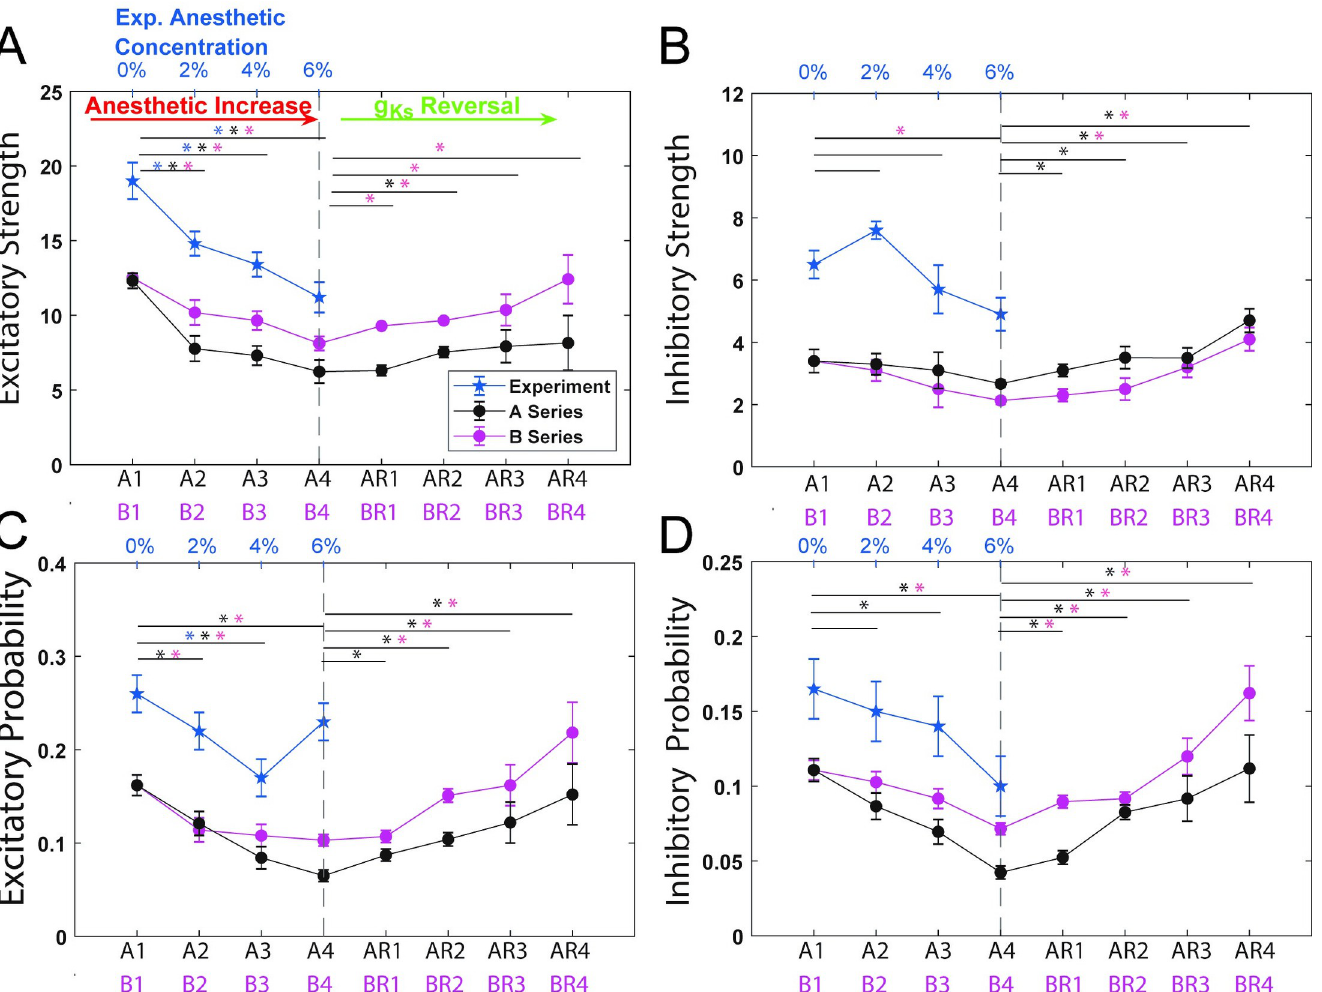
Fig 5. Characterization of anesthetic effects on network connectivity and their simulated ACh reversal. Measures of network connectivity computed from experimental data and optimized model networks as a function of anesthetic concentration and simulated reversal level: A) network excitatory connectivity strength, B) network inhibitory connectivity strength, C) network excitatory connectivity probability, D) network inhibitory connectivity probability. A1-AR4/B1-BR4 (x-axis) denote simulated anesthetic concentration levels and reversal states obtained in optimized networks with corresponding parameters listed in Table 2 . Blue line (with corresponding axis labels on the top) denotes measures computed from experimental data, black (pink) line denotes measures computed from A-series (B-series) network simulations. In these measures, the presence of a significant connection was determined through cross correlogram analysis as described in Methods section. Stars denote significance between initial anesthetic/reversal and subsequent simulations. Error bars of +/- SEM based on 10 network realizations for best fit optimization.